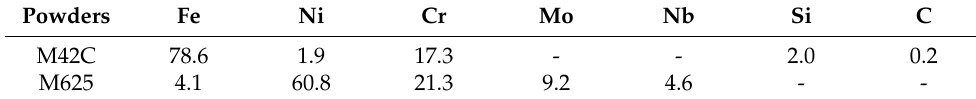
Table 1. Chemical composition (wt.%) of the FGM powder alloys used in this study.